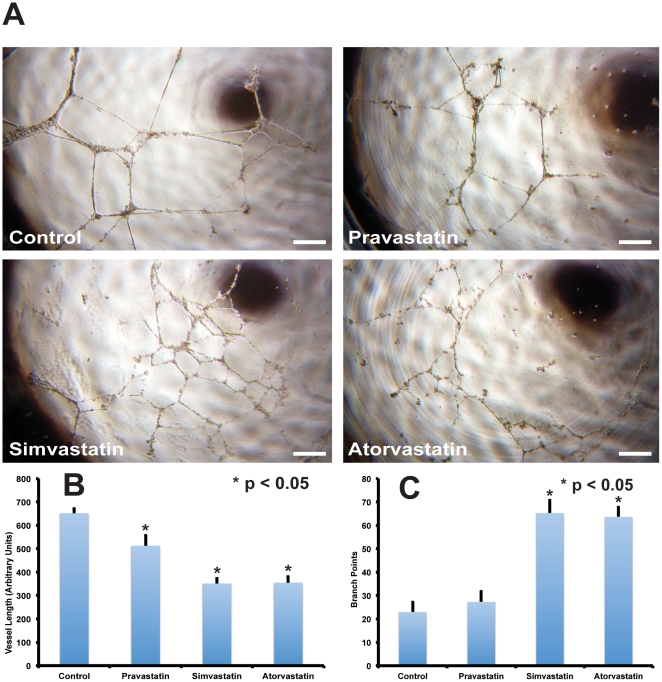
Statins Differentially Affect Angiogenesis of LOEPCs in Vitro.
Panel A: Representative photomicrographs of porcine LOEPCs plated on polymerized Matrigel for 24 hours with no drug treatment (Control), or Pravastatin, Simvastatin or Atorvastatin (100 nM each). Images are representative of three independent experiments. Scale bar = 500 microns. Panel B: Mean vessel length was measured from photomicrographs. Means +/− SEM are shown for three independent experiments. Significant differences from untreated cells (Control) are indicated by * (p<0.05). Panel C: Branch Point Determination-the number of branch points within LOEPCs plated on Matrigel was determined from each photomicrograph. The means +/− SEM are shown for three experiments. Significant differences from untreated cells (Control) are indicated by * (p<0.05).